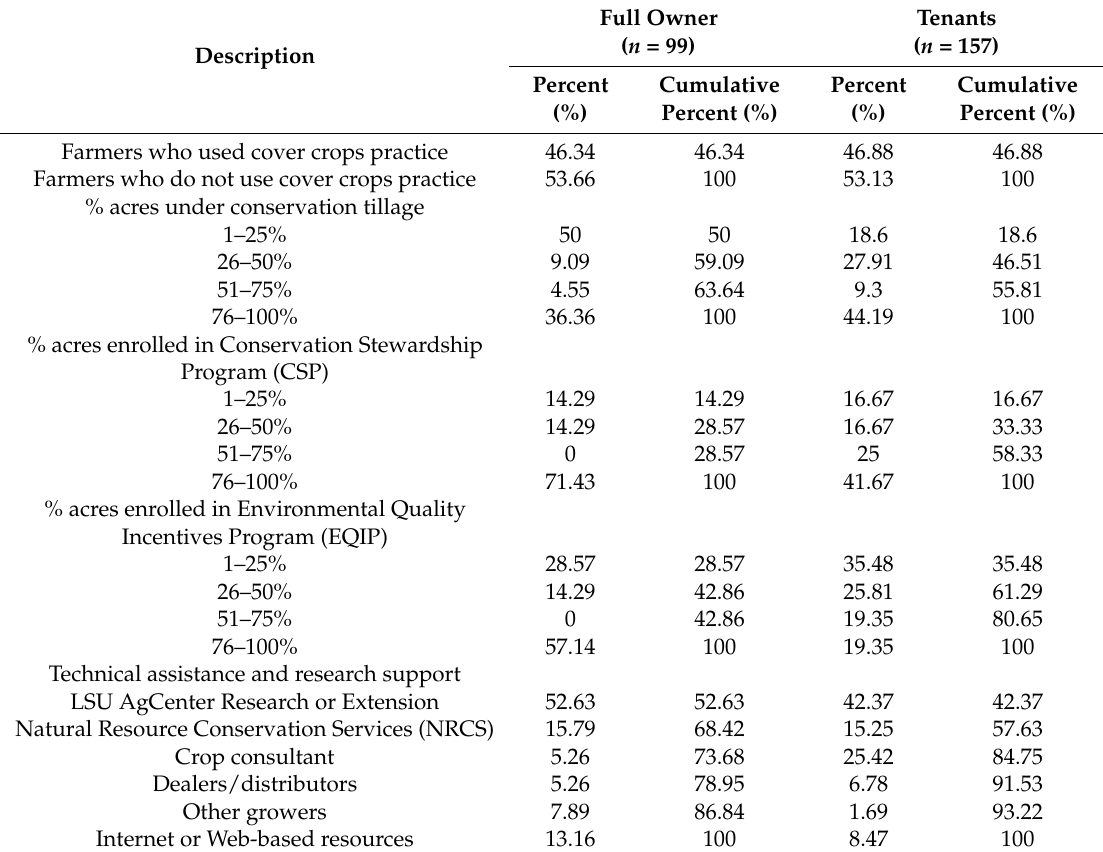
Table 1. General Farm-Management Characteristics of